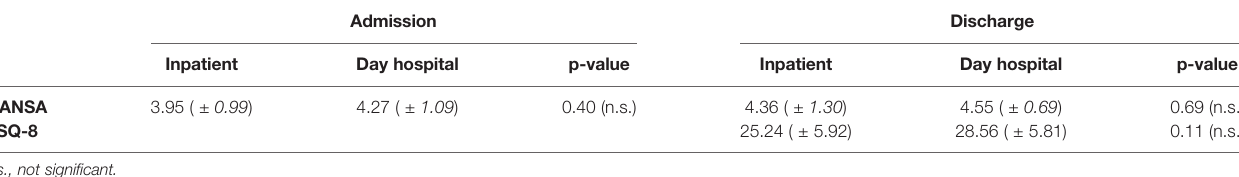
TABLE 7 | Manchester Short Assessment of Quality of Life (MANSA), mean scores (± standard deviation , and Client Satisfaction Questionnaire (CSQ-8), mean sum scores (± standard deviation), p-values (t-tests, inpatient versus day hospital).